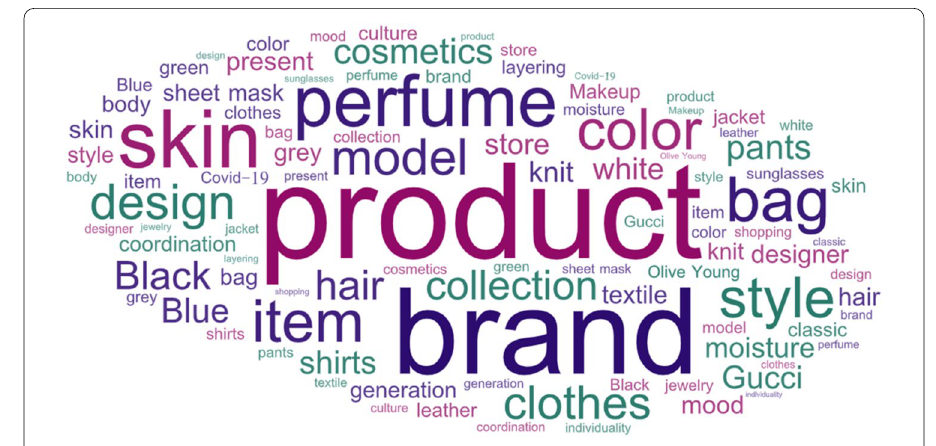
Fig. 4 Word cloud visualization results